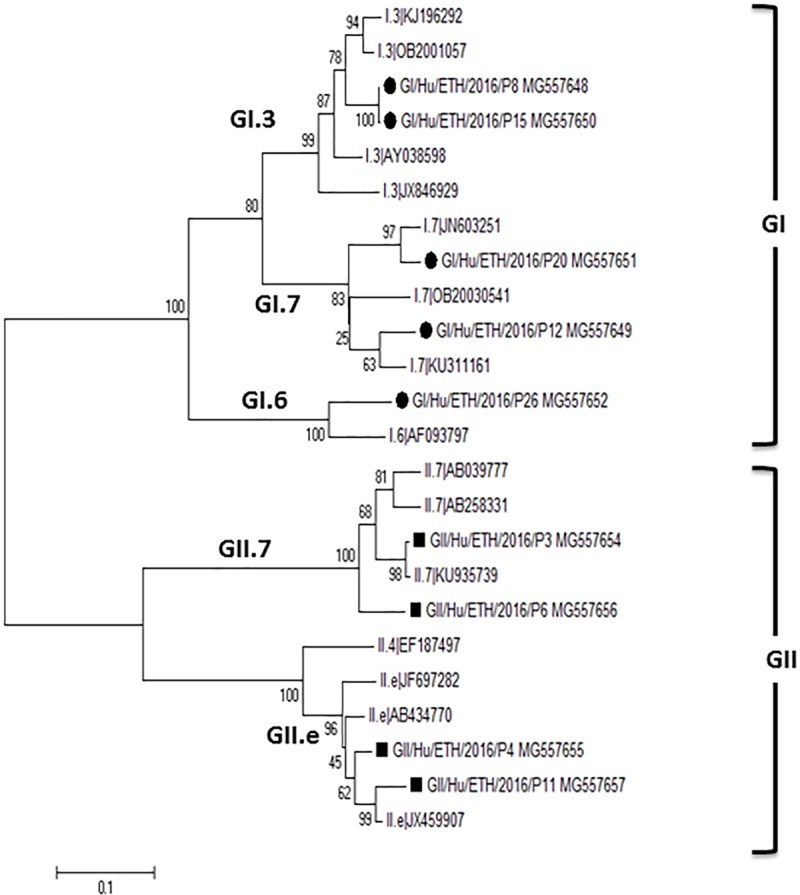
Phylogenetic analysis of RdRp from different genotypes of noroviruses.Viral sequences described here are highlighted by black diamonds.